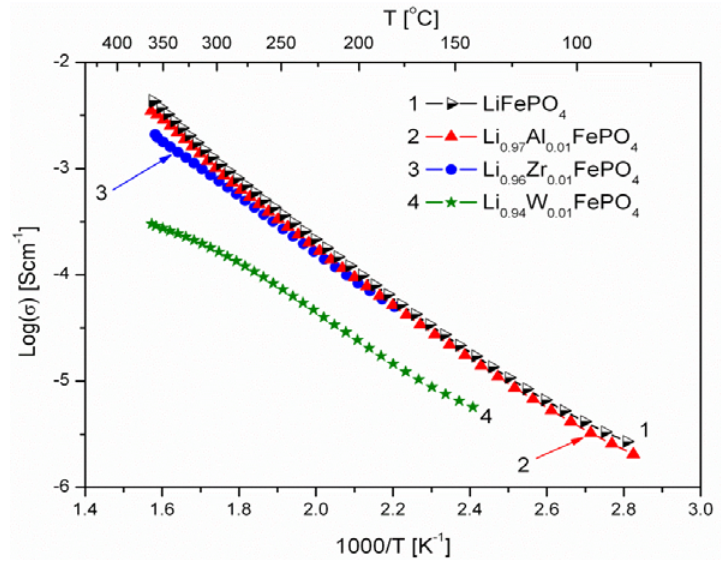
Figure 8. Temperature dependence of electrical conductivity of Li-site substituted phosphoolivines with x = 0.01 mol mol − 1 .